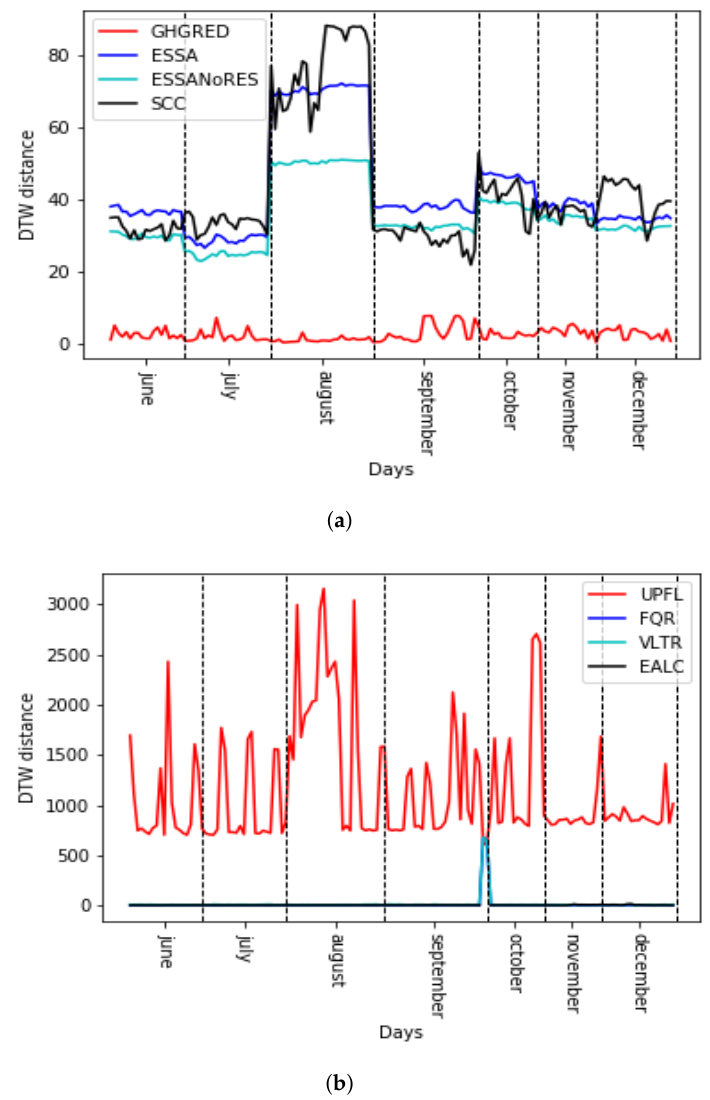
Figure 13. Dynamic Time Warping distance for two sets of KPIs. ( a ) GHGRED, ESSA, ESSANoRES, SCC and ( b ) UPFL, FQR, VLTR,